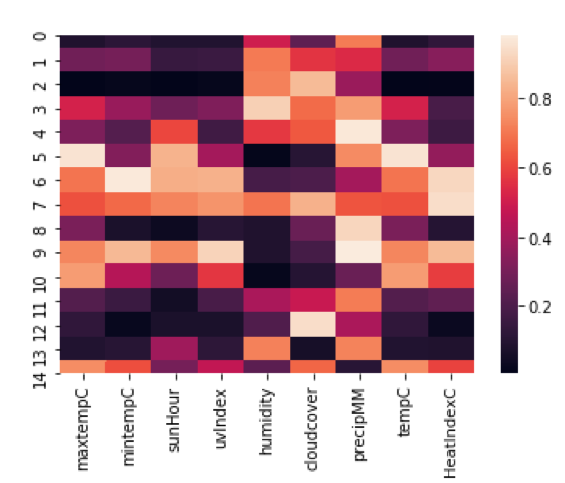
Figure 7. Weekly correlation confidence for nine weather attributes with cholera disease incidence.